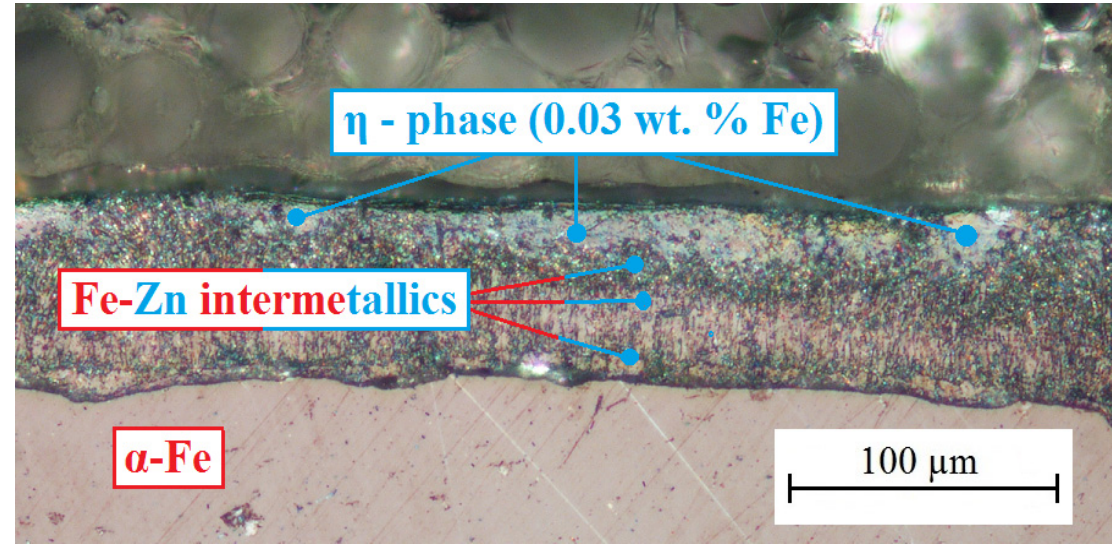
Figure 4. Cross section of hot-dip galvanized coating on the surface of plain bars.